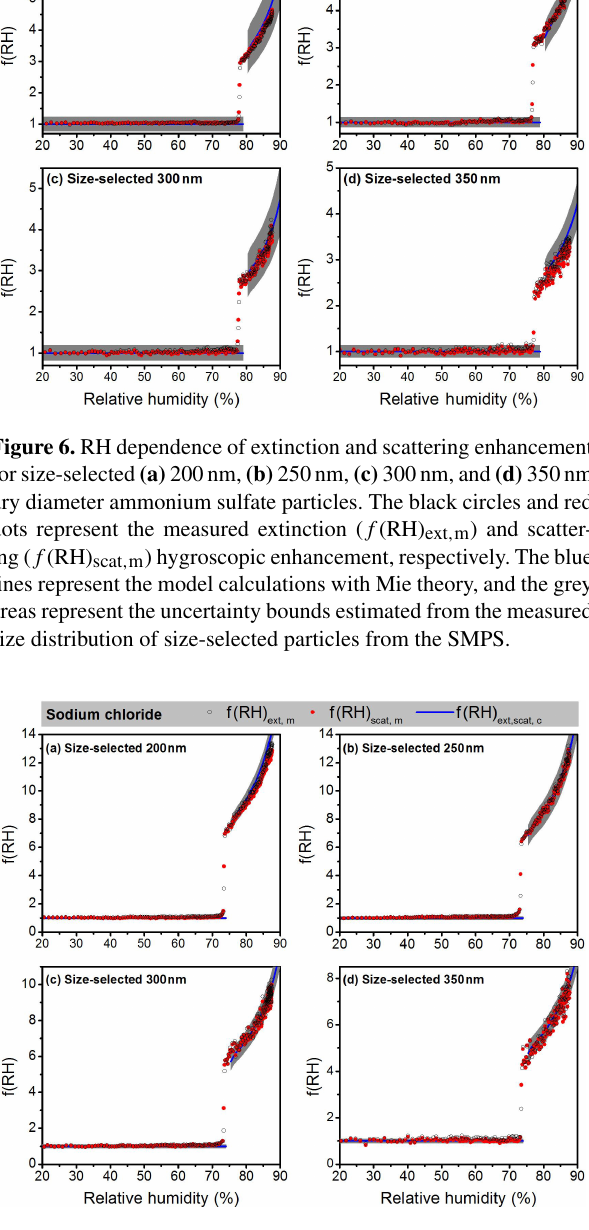
Figure 7. RH dependence of extinction and scattering enhancement for size-selected (a) 200nm, (b) 250nm, (c) 300nm, and (d) 350nm dry diameter sodium chloride particles. The black circles and red dots represent the measured extinction ( f (RH) ext , m ) and scatter- ing ( f (RH) scat , m ) hygroscopic enhancement, respectively. The blue lines represent the model calculations with Mie theory, and the grey areas represent the uncertainty bounds estimated from the measured size distribution of size-selected particles with SMPS.